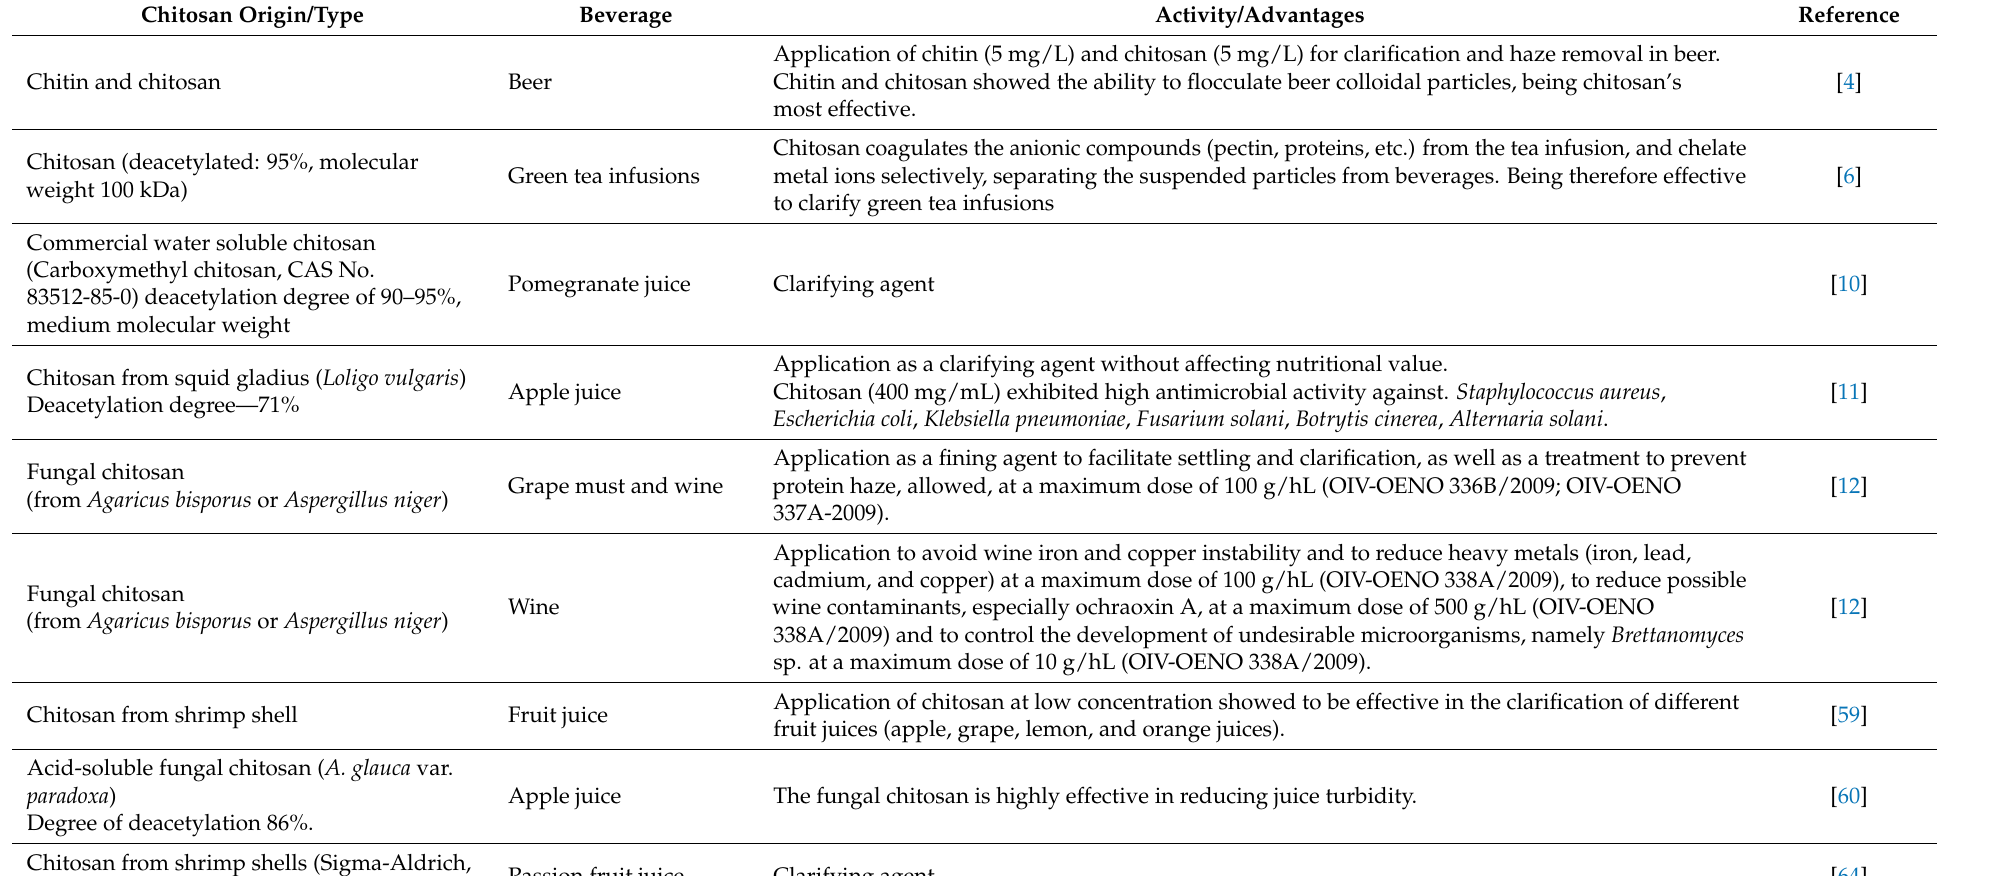
Table 1. Chitosan origin and type, activity/advantages of application in